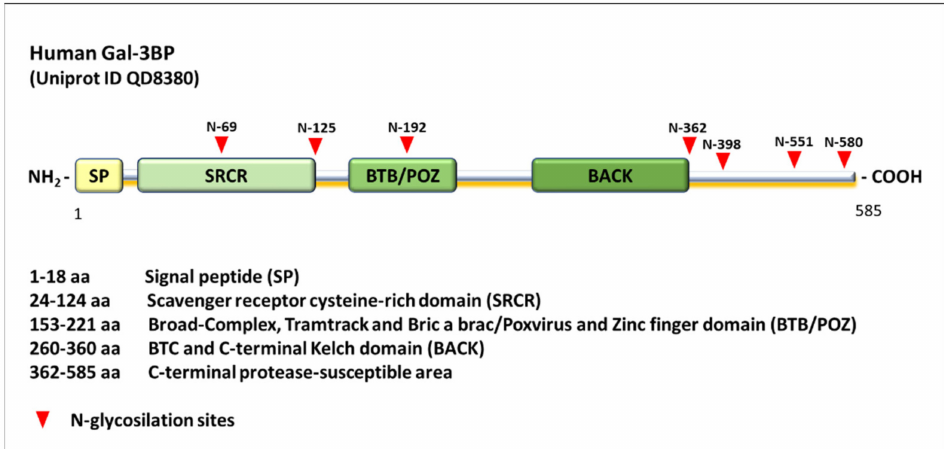
Figure 1. Human Gal-3BP’s structure consists of three main functional domains: an N-terminal scavenger receptor cysteine-rich (SRCR) domain, a BTB/POZ (broad-complex, tramtrack and bric-a- brac/poxvirus and zinc finger) domain and a BACK domain (BTB and C-terminal Kelch domain). In addition, there is an N-terminal 18 amino acid signal peptide that is cleaved after translation and a C-terminal protease-susceptible